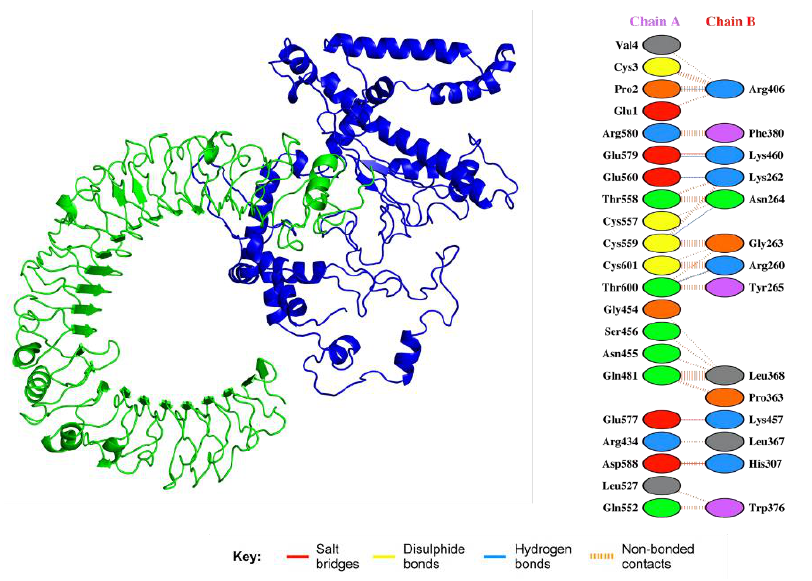
Figure 7. Interaction between the vaccine and TLR. The green represents the TLR, while the blue color shows the multi-epitope vaccine construct. Specific interactions are given in the right-hand panel. Salt bridges, disulphide bonds, and hydrogen bonds are shown in different colors.